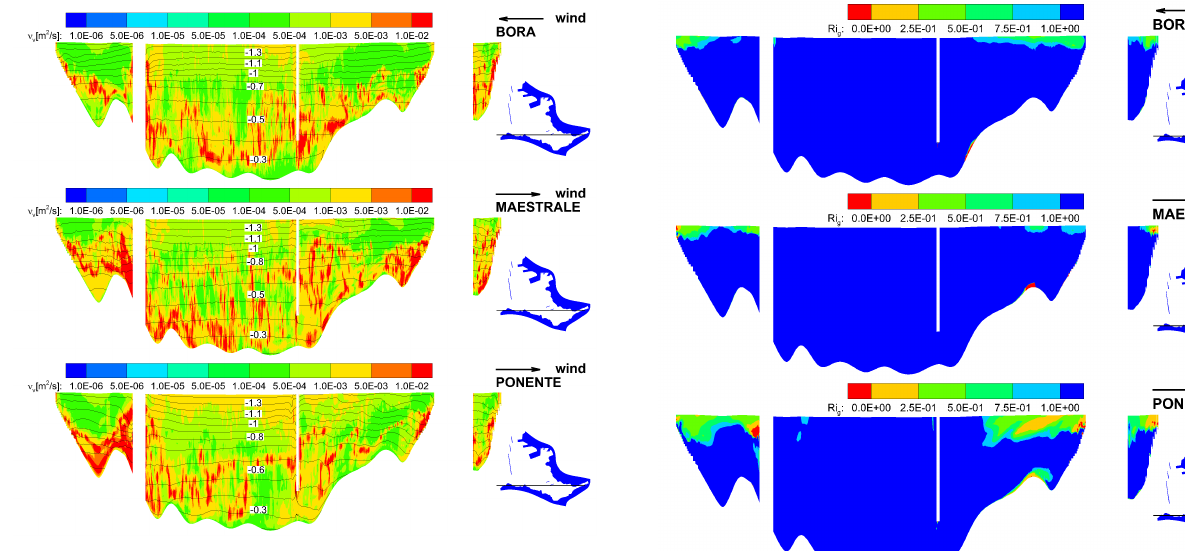
Fig. 21. Contour plot for the gradient Richardson number, averaged on a time of 3 hours, in the vertical cut indicated in the small picture on the right side. From top to bottom the plots refer to Bora, Maes- trale and Ponente scenarios. The vertical direction is magnified by a factor 100.